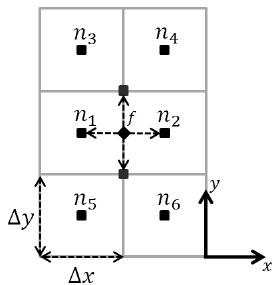
Figure 4. Schematic of central differences in a cartesian mesh. The central node on each volume are indicated, n i , for the six cells considered. The derivative at the faces are computed using the nearest nodes.